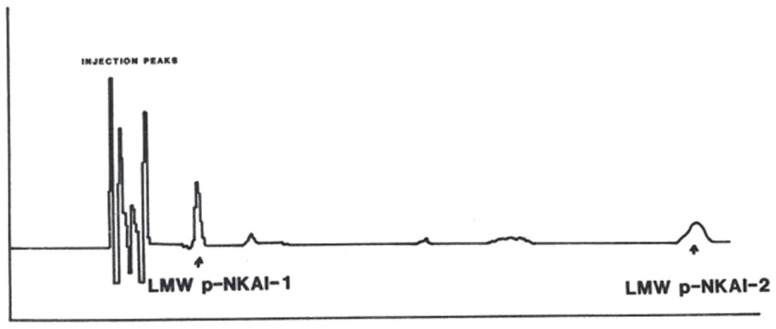
Elution of semi-purified LMW p-NKAI, monitored electrochemically. Arrows indicate the loci of p-NKAI-1 and p-NKAI-2. From Ref. (10) with permission from the editors.